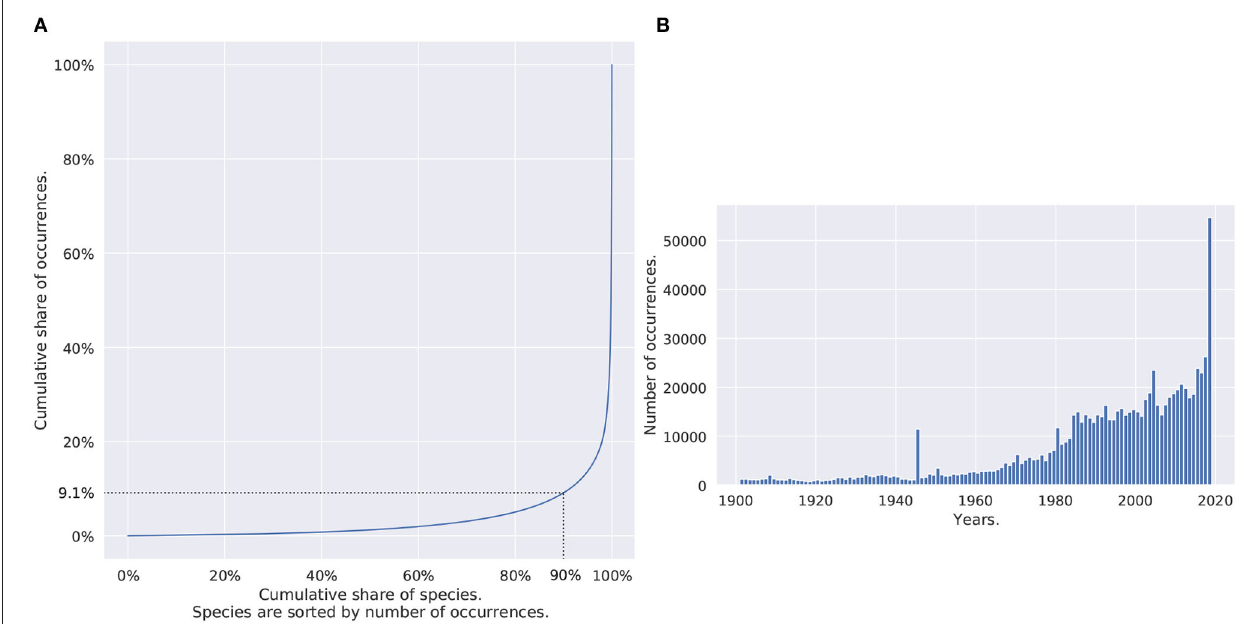
FIGURE 2 | (A) Distribution of Occurrences of species. Species are ordered by frequency. The dotted lines are flagging that 90% of the species are only gathering 9.1% of the occurrences. (B) Temporal distribution of occurrences. The two graphs are based on all dataset